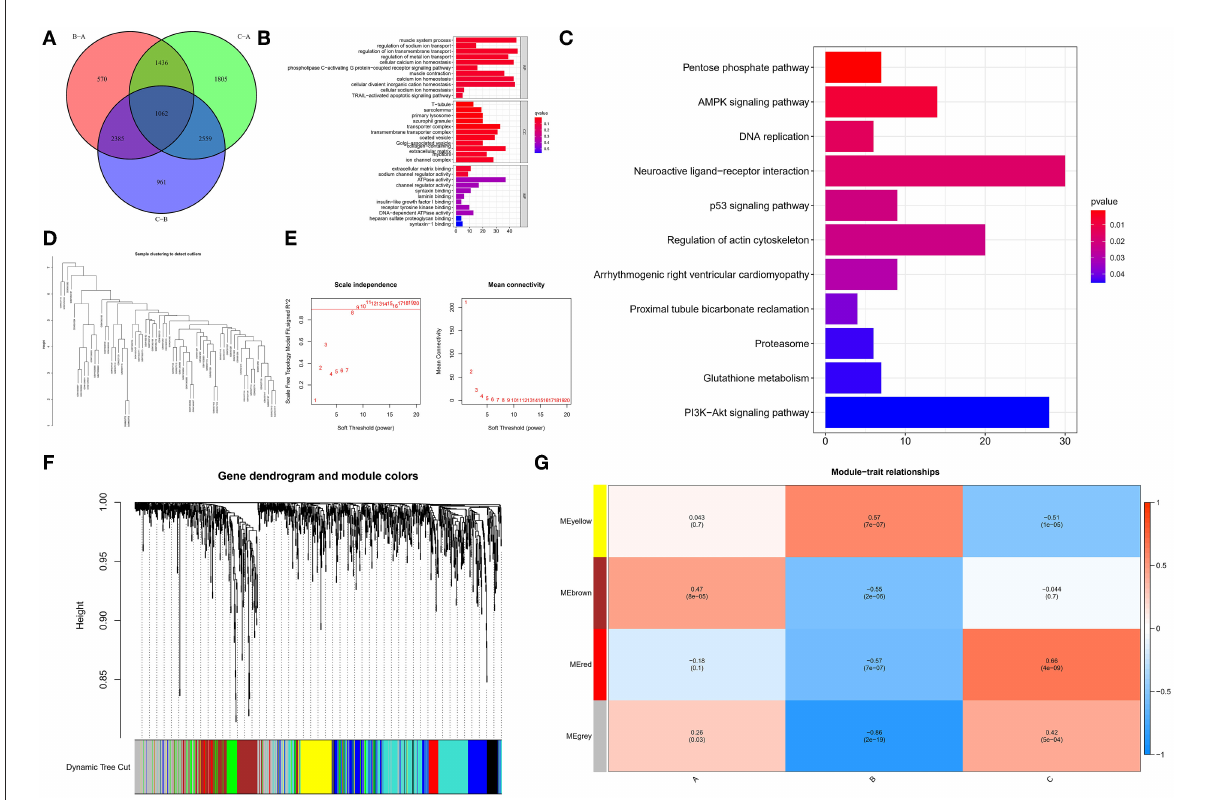
FIGURE9 Determination and functional analysis of genes associated with the m6A phenotype in IA. (A) Venn diagram of 1,062 genes associated with the m6A phenotype. (B) Assessment of GO-BP, CC, and MF functional enrichment of the biological features of genes associated with the m6A phenotype. (C) KEGG enrichment analysis of immune genes associated with the m6A phenotype to elucidate the correlation between m6A modulators and immunological modulation. (D) Clustering of samples according to the expression data from all samples. WGCNA analyzed the top 25% of variation genes, excluding outlier data. (E) The scale-free ft-index, as well as the mean connectivity, were analyzed for a range of soft-thresholding powers. (F) Gene dendrogram generated using hierarchical clustering based on average linkage. The color row below the dendrogram indicates the module allocation established by the Dynamic Tree Cut, which identified four modules. (G) Heatmap of the correlation between module eigengenes and m6A modification patterns.